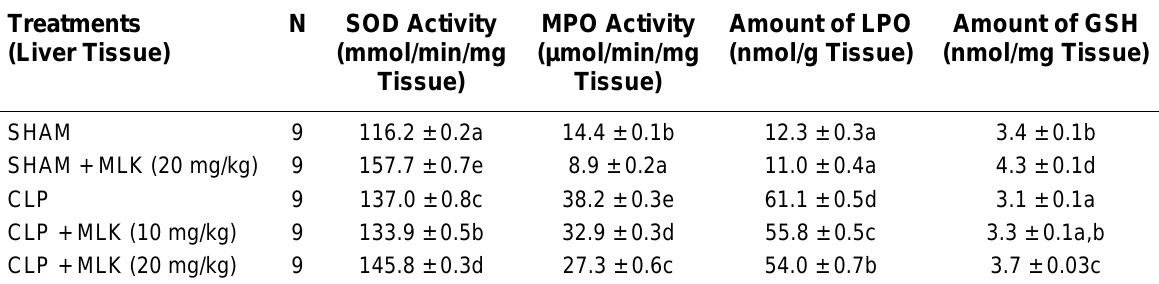
Effects of MLK Treatments on Changes in Activities of MPO and SOD, and with Levels of LPO and GSH in Liver Tissues of Rats